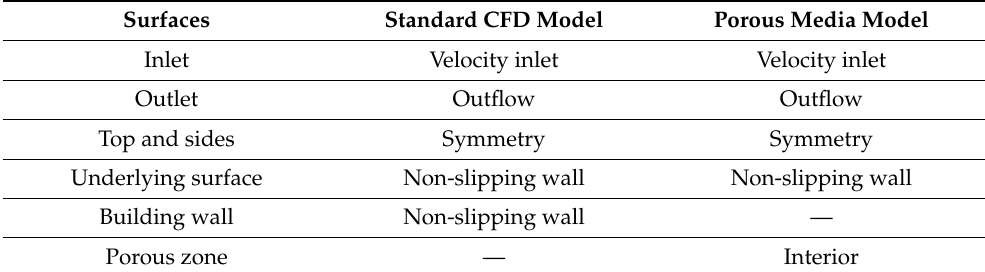
Table 1. Setting of boundary conditions.